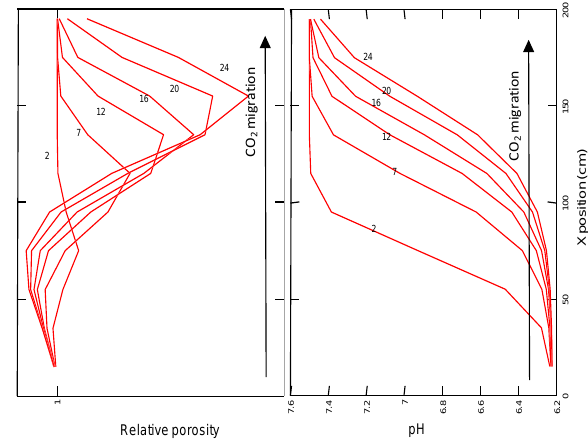
Figure 7. Relative porosity, and pH changes along the flow path of CO 2 injected into the zone of